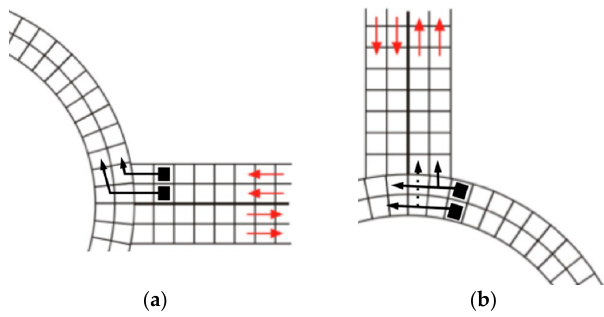
Figure 5. Scenario 4: possible directions of vehicle movement in the roundabout ( a ) enter; ( b ) exit.